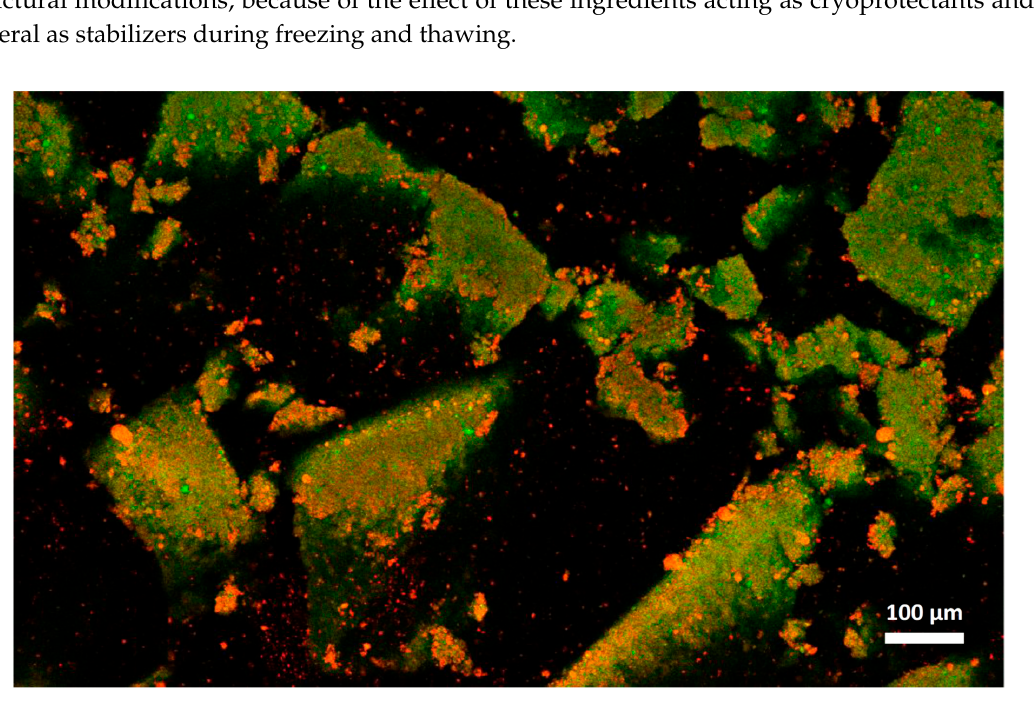
Figure 6. Microstructure of cream cheese A observed with confocal laser scanning microscope after freezing and thawing. Red: fat. Green: protein.